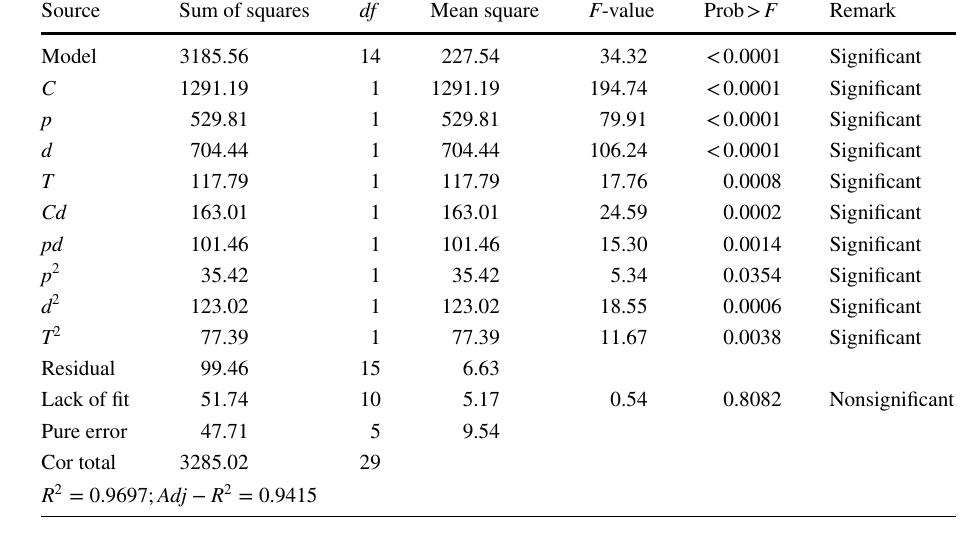
Table 5 Analysis of variance (ANOVA) for fit of Cr(VI) removal efficiency from central composite design